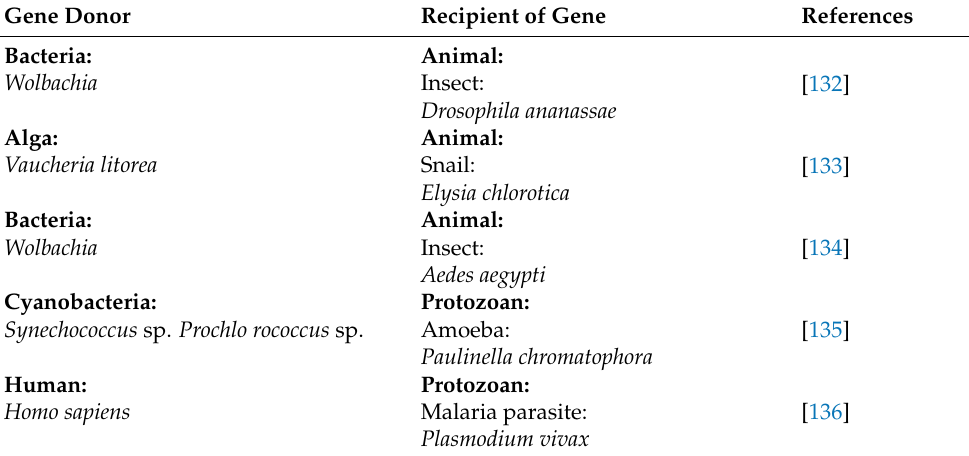
Table A1. Cont . Gene Donor Recipient of